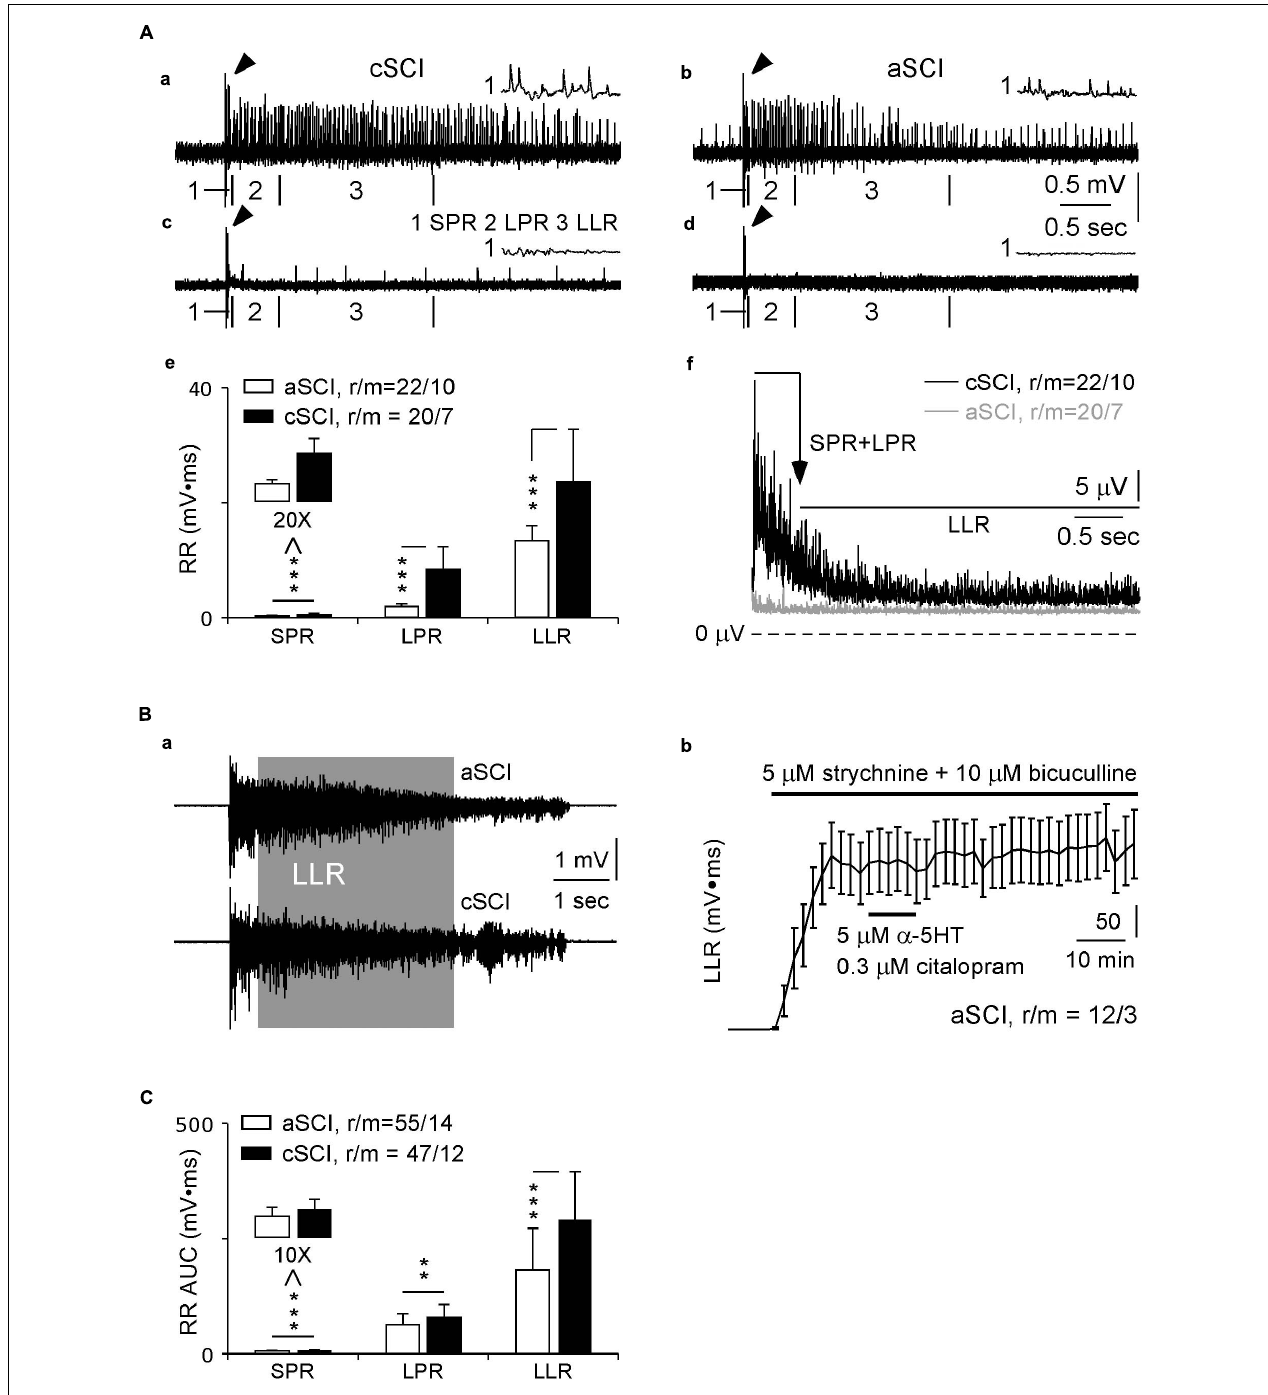
FIGURE 1 | Evoked root reflexes. (A) Ventral root recordings without blocking inhibitory synapses. Four sample recordings from 2 cSCI mice (a,c) and 2 aSCI mice (b,d) display the effects of single stimulation at 3X on root reflexes, in which the LLR was evoked in (a–c), but not in (d). The histogram in (e) shows AUC values of rectified root reflexes for each component in aSCI and cSCI mice. The plots in f display rectified and averaged root reflexes in duration of 10–4,000 ms. (1) arrows indicate stimulus artifact; (2) the artifacts and mono-synaptic reflexes are truncated; (3) the insets marked by number (1) show expanded SPR, and number (2–3) with boundary bars indicate the locations of LPR and LLR. (B) The root reflexes after blocking inhibitory synapses. Two sample recordings in a display full length of root reflexes from both aSCI and cSCI mice. The plot in (b) shows stable recordings of LLRs from 12 ventral roots in three aSCI mice. (C) The histograms compare three components of root reflexes between aSCI and cSCI mice. Significant difference was determined by unbalanced two way ANONA (mouse type: p = 1.17 × 10 − 7 , components: p = 2.45 × 10 − 7 ) and asterisks represent the significance of post hoc t -tests (** p < 0.01, *** p < 0.001). r/m, roots/mice; error bars, SD.